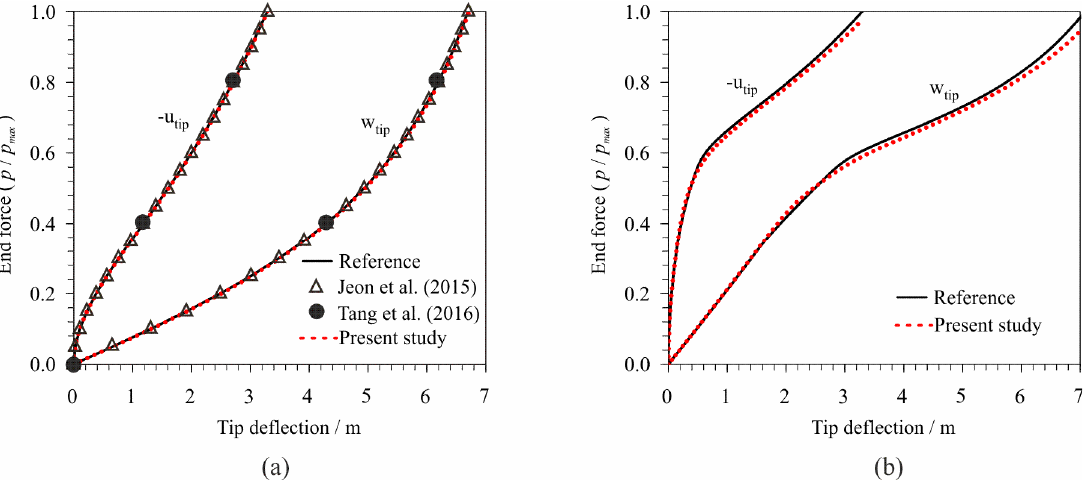
Figure 18. Tip deflection in relation to the end force: ( a ) linear-elastic material; and ( b ) nonlinear material.